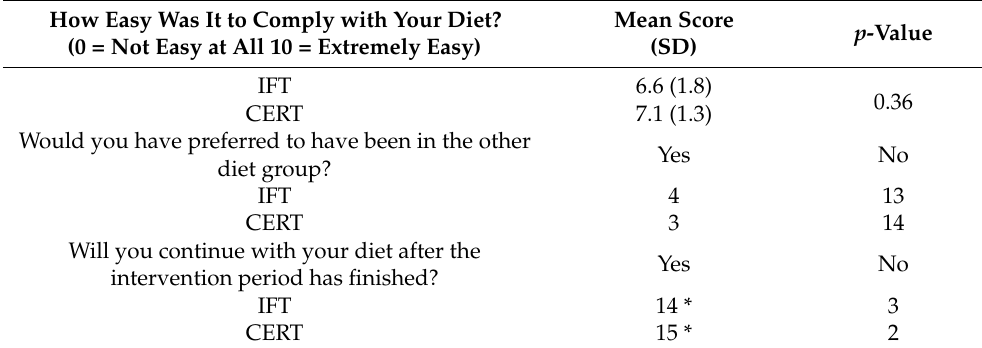
Table 8. Post-intervention questionnaire responses to the dietary intervention in IFT and CERT